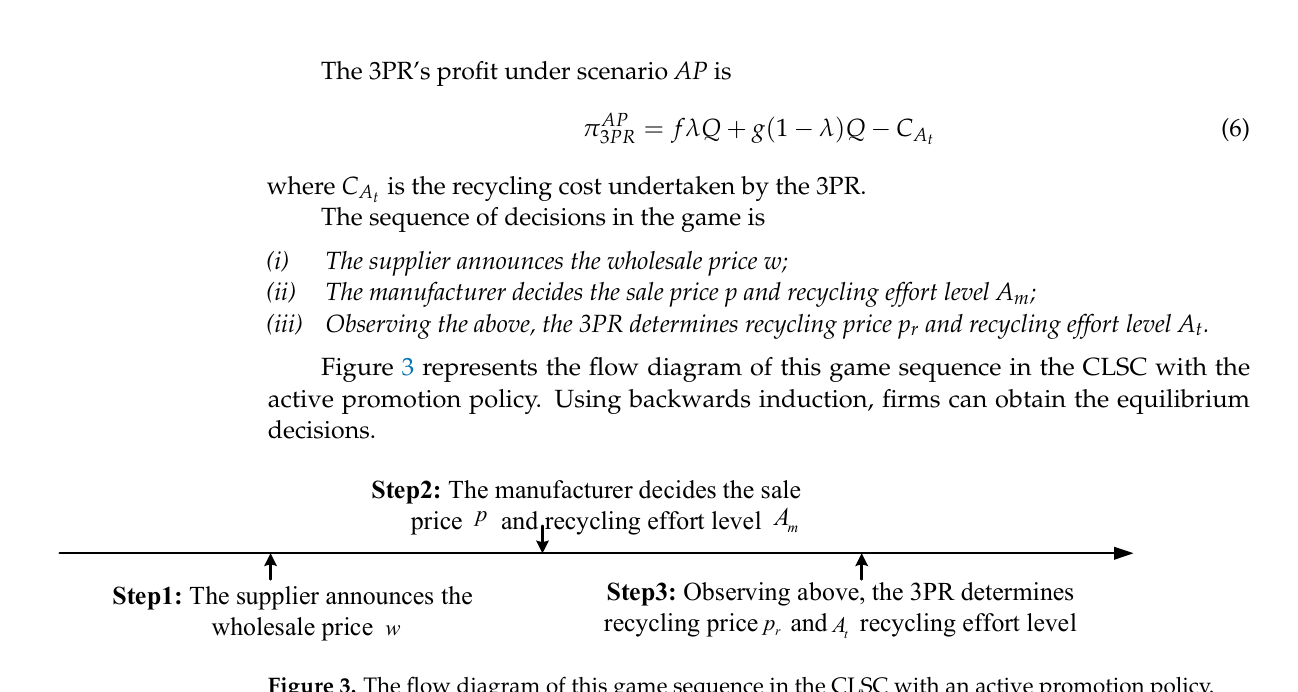
Figure 3. The flow diagram of this game sequence in the CLSC with an active promotion policy.